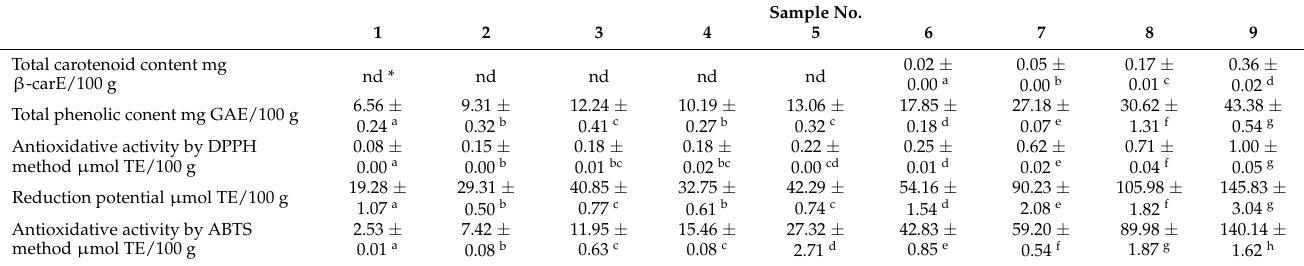
Table 3. Content of total carotenoid and polyphenol compounds and antioxidative activity of cookies with and without the addition of L and OL